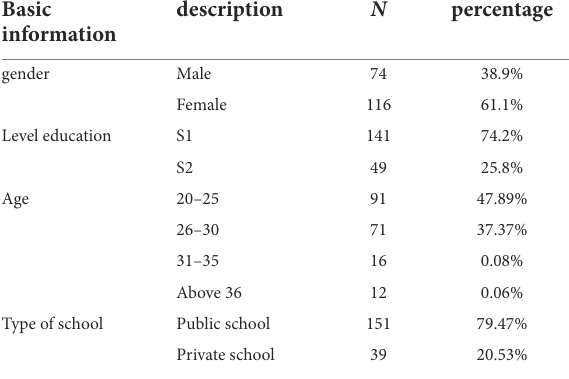
TABLE 1 Data demographics